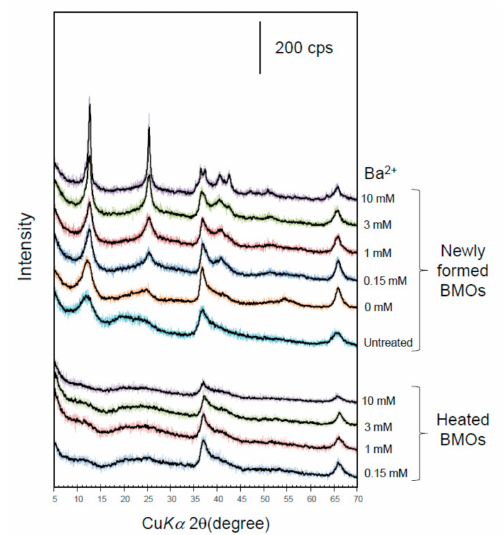
Figure 4. X-ray diffractograms from analysis of the newly formed and heated biogenic manganese oxides (1 mM as Mn) treated thrice with mixtures of Ba(NO 3 ) 2 (0–10 mM) and 1 mM Mn(NO 3 ) 2 in 20 mM HEPES (pH 7.0). The bathing solutions were renewed every 24 h.